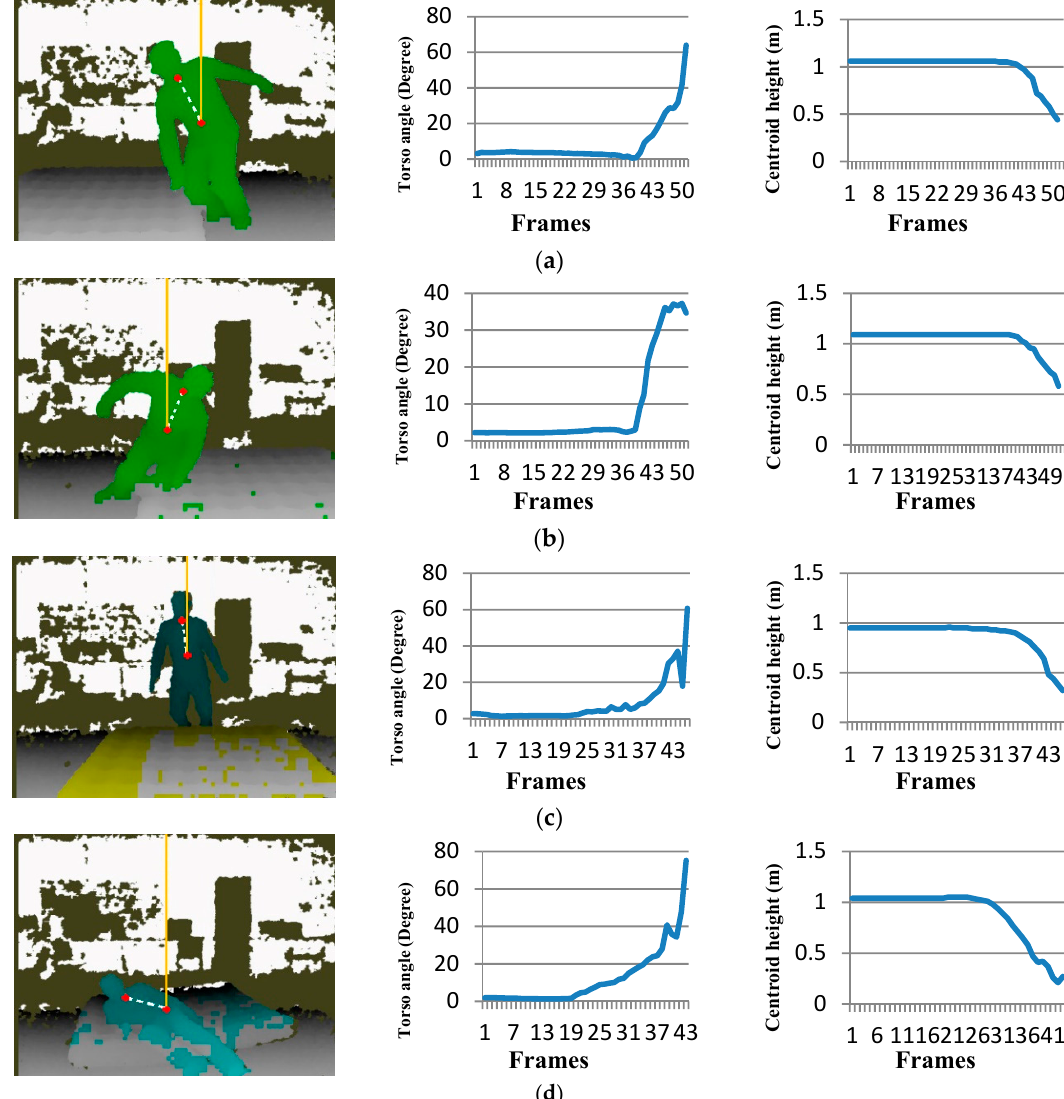
Figure 9. Detected frames of different falls and two features’ curves. The left picture of each group is the depth image of the frame when our method detected the fall. The dotted line in the depth image stands for the torso line, while the solid line stands for the gravity line. Shoulder center joint and hip center joint were marked in red. ( a ) Fall left; ( b ) fall right; ( c ) fall forward; ( d ) fall backward.